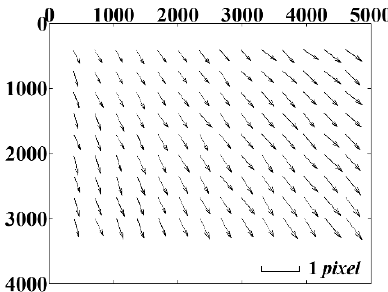
Figure 4. Pixel drifts under real experimental conditions.